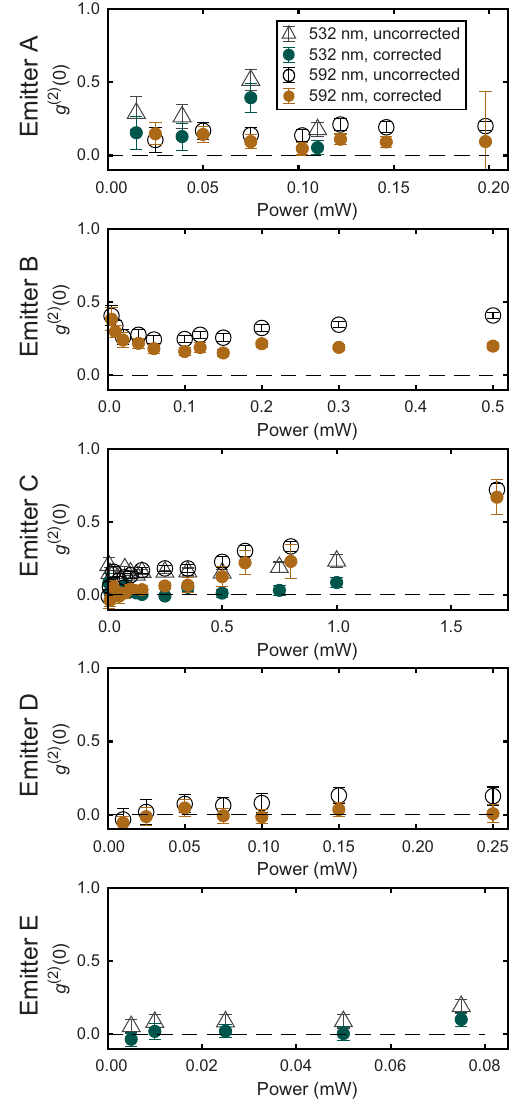
FIG. 4. Single-photon emission characteristics. Zero-delay photon autocorrelation function as a function of optical excita- tion power. The open circles (triangles) represent uncorrected g ( 2 ) ( 0 ) for excitation at 592 nm (532 nm). The orange (green) solid circles represent background and IRF corrected g ( 2 ) ( 0 ) for excitation at 592 nm (532 nm). Error bars represent one standard deviation derived from fits, as described in the